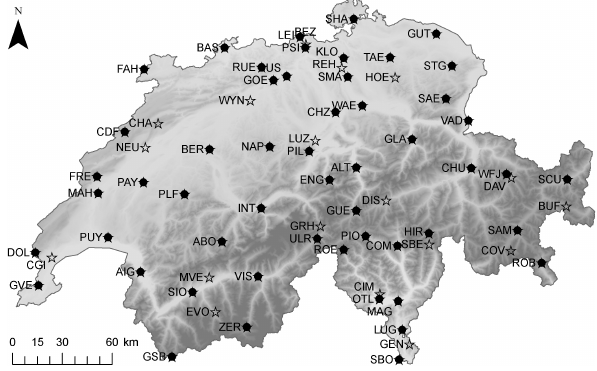
Fig. 1. Location of automatic rainfall stations in Switzerland (star dots are stations used for the validation of the rainfall erosivity